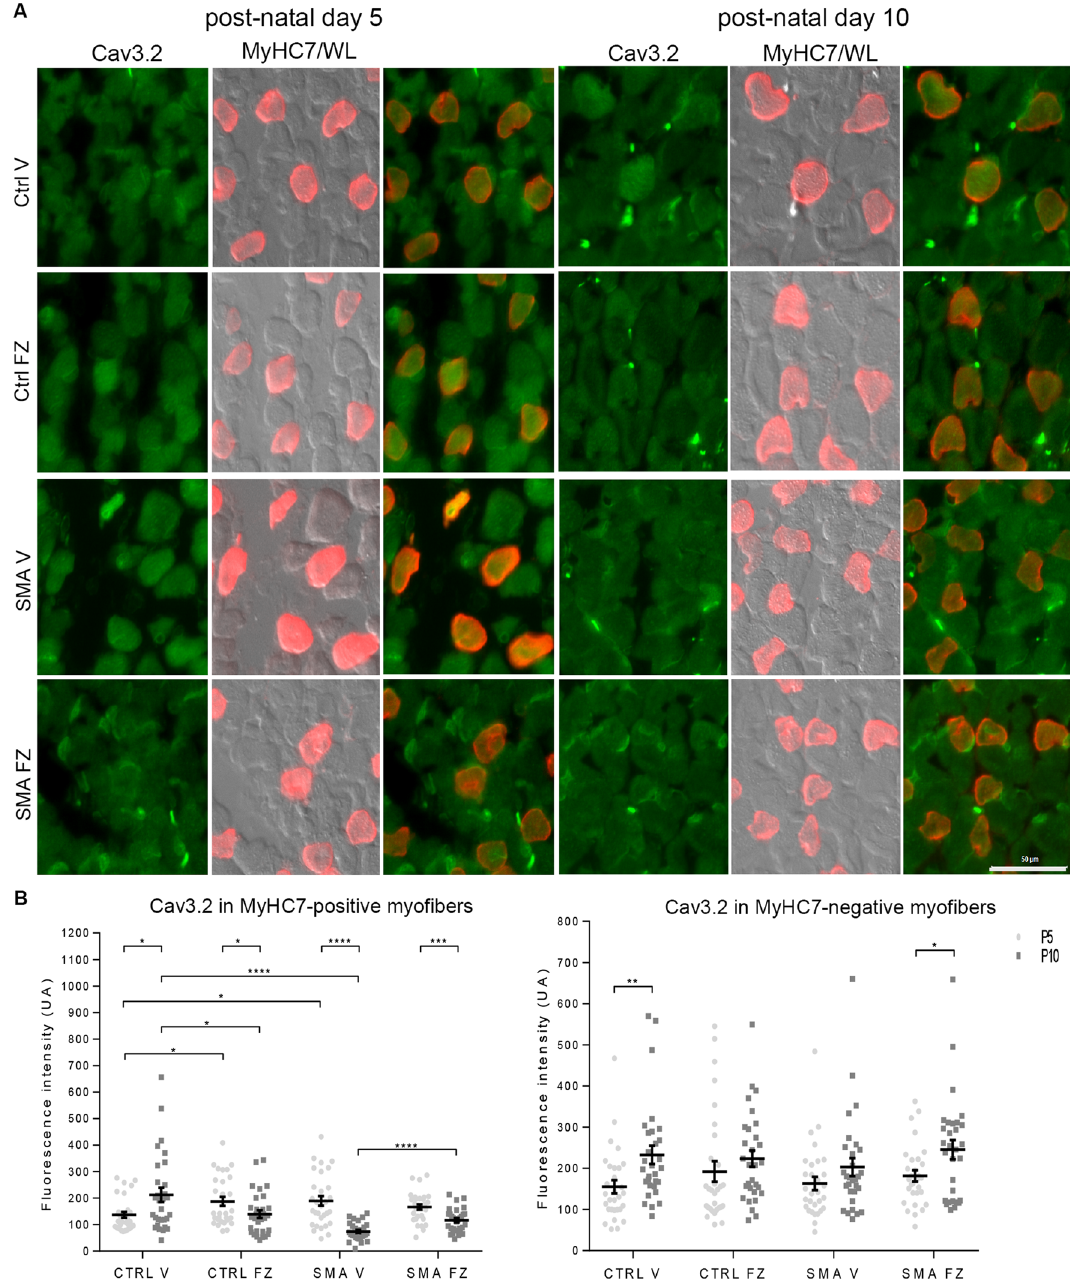
Figure 4. Flunarizine prevents the reduction of myofiber Cav3.2 immunolabelling during neonatal development in SMA mice. ( A) Muscle fiber immunostaining with Cav3.2 (green) and MyHC7 (red) is shown for the plantaris from vehicle (V)- and flunarizine (FZ)-treated control and SMA mice at P5 and P10, respectively. The original images are presented in supplemental Fig. 8. ( B) Normalized fluorescence intensity of individual muscle fibers for Cav3.2 detected in panel A is shown. Each symbol represents total value of fluorescence intensity in a fiber. The mean value of fluorescence is in supplemental Fig. 9. The distribution for the 4 groups of mice of MyHC7 immunolabelled or unlabeled fibers is compared using Student’s t-test. NS not significant (P > 0.05), *P < 0.05, **P < 0.01, ***P < 0.001 (3 mice per group). Scale bar, 50